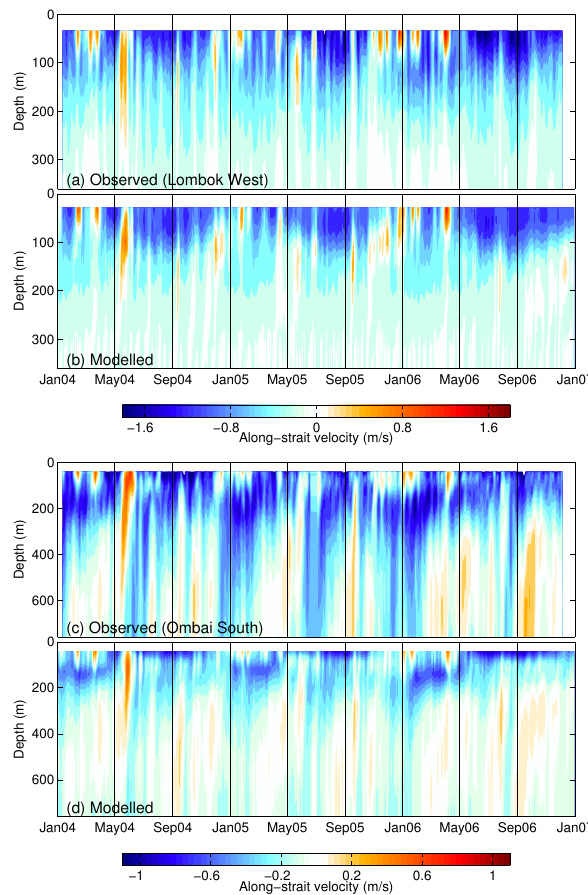
Fig. 8. Time series of (a, c) observed and (b, d) modelled along- Fig. 8. Time-series of (a,c) observed and (b,d) modelled along-strait velocity at Lombok (a-b; 115 ◦ 45.55 0 W, strait velocity at Lombok ( a–b ; 115 ◦ 45 . 55 0 W, 8 ◦ 26 . 34 0 S) and Om- 8 ◦ 26.34 0 S)andOmbai(c-d;125 ◦ 0.384 0 E,8 ◦ 38.1 0 S)StraitduringtheINSTANTprogram(Gordonetal.,2010). bai ( c–d ; 125 ◦ 0 . 384 0 E, 8 ◦ 38 . 1 0 S) Strait during the INSTANT pro- Negative (blue) velocities indicate flow towards the Indian Ocean, and positive (red) velocities are towards the gram (Gordon et al., 2010). Negative (blue) velocities indicate flow Indonesian Seas. towards the Indian Ocean, and positive (red) velocities are towards the Indonesian 36